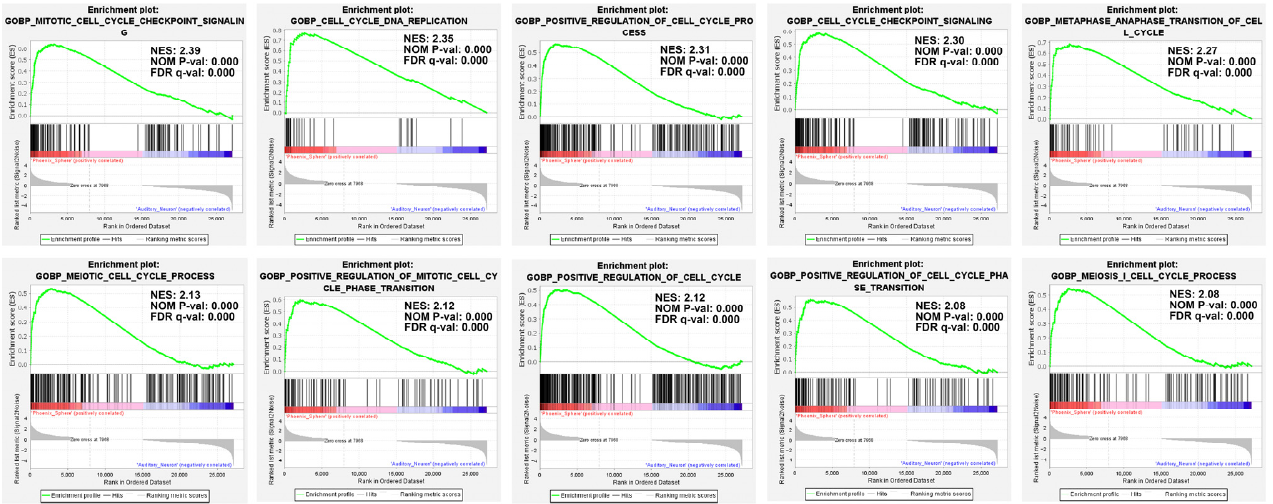
Figure 5. GSEA enrichment plot. In the phoenix sphere group, the top 10 significantly up-regulated gene sets from the cell cycle collection were demonstrated. The mitotic cell cycle checkpoint signalling, cell cycle DNA replication, and positive regulation of the cell cycle process are the leading gene sets. Table 3. Node, edge, and score of the top 5 sub-clusters. Cluster